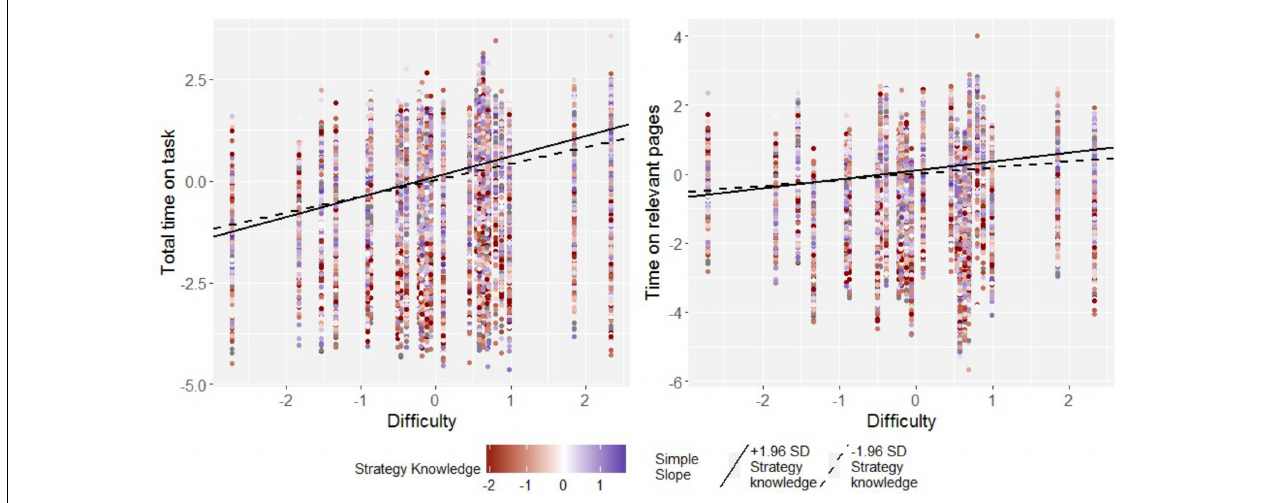
FIGURE 5 | Simple slopes for the regression of total time on task and time on relevant pages on task difficulty in students high (97.5th perc.) and low (2.5th perc.) in knowledge of reading strategies for one sample country (Australia). Data points are raw data. Regression intercepts and slopes are model-based estimates.